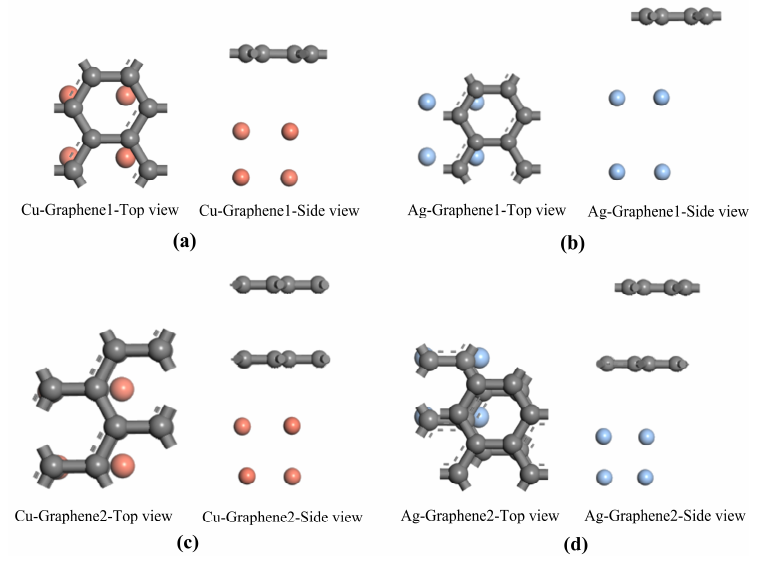
Figure 2. Optimized models of four composite electrode plates: ( a ) single-layer graphene copper- clad electrode plate; ( b ) single-layer graphene silver-clad electrode plate; ( c ) double-layer graphene copper-clad electrode plate; ( d ) double-layer graphene silver-clad electrode plate.